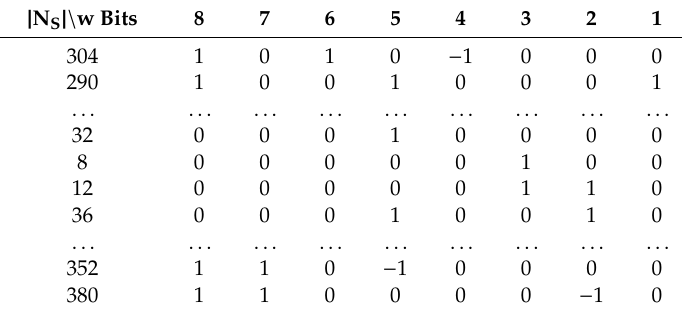
Table 4. Generating Ns using 3 active bits in 32